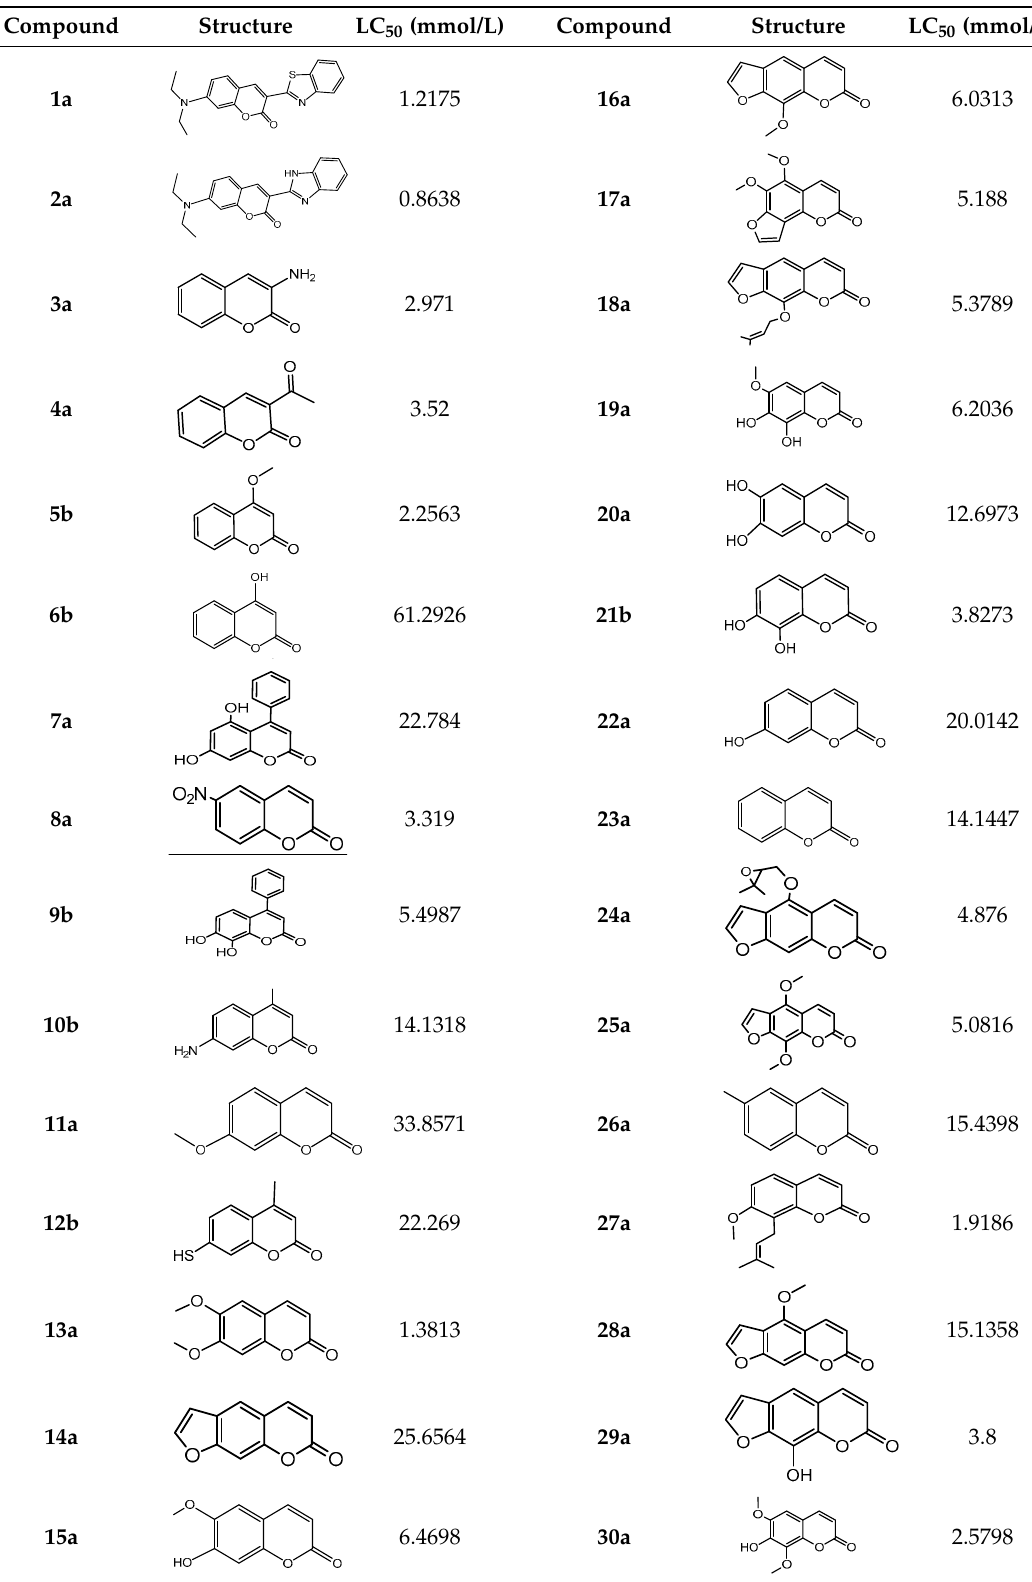
Table 3. Summary of the results obtained from CoMFA (comparative molecular fi eld analysis) and CoMSIA (comparative molecular similarity index analysis) analyses.